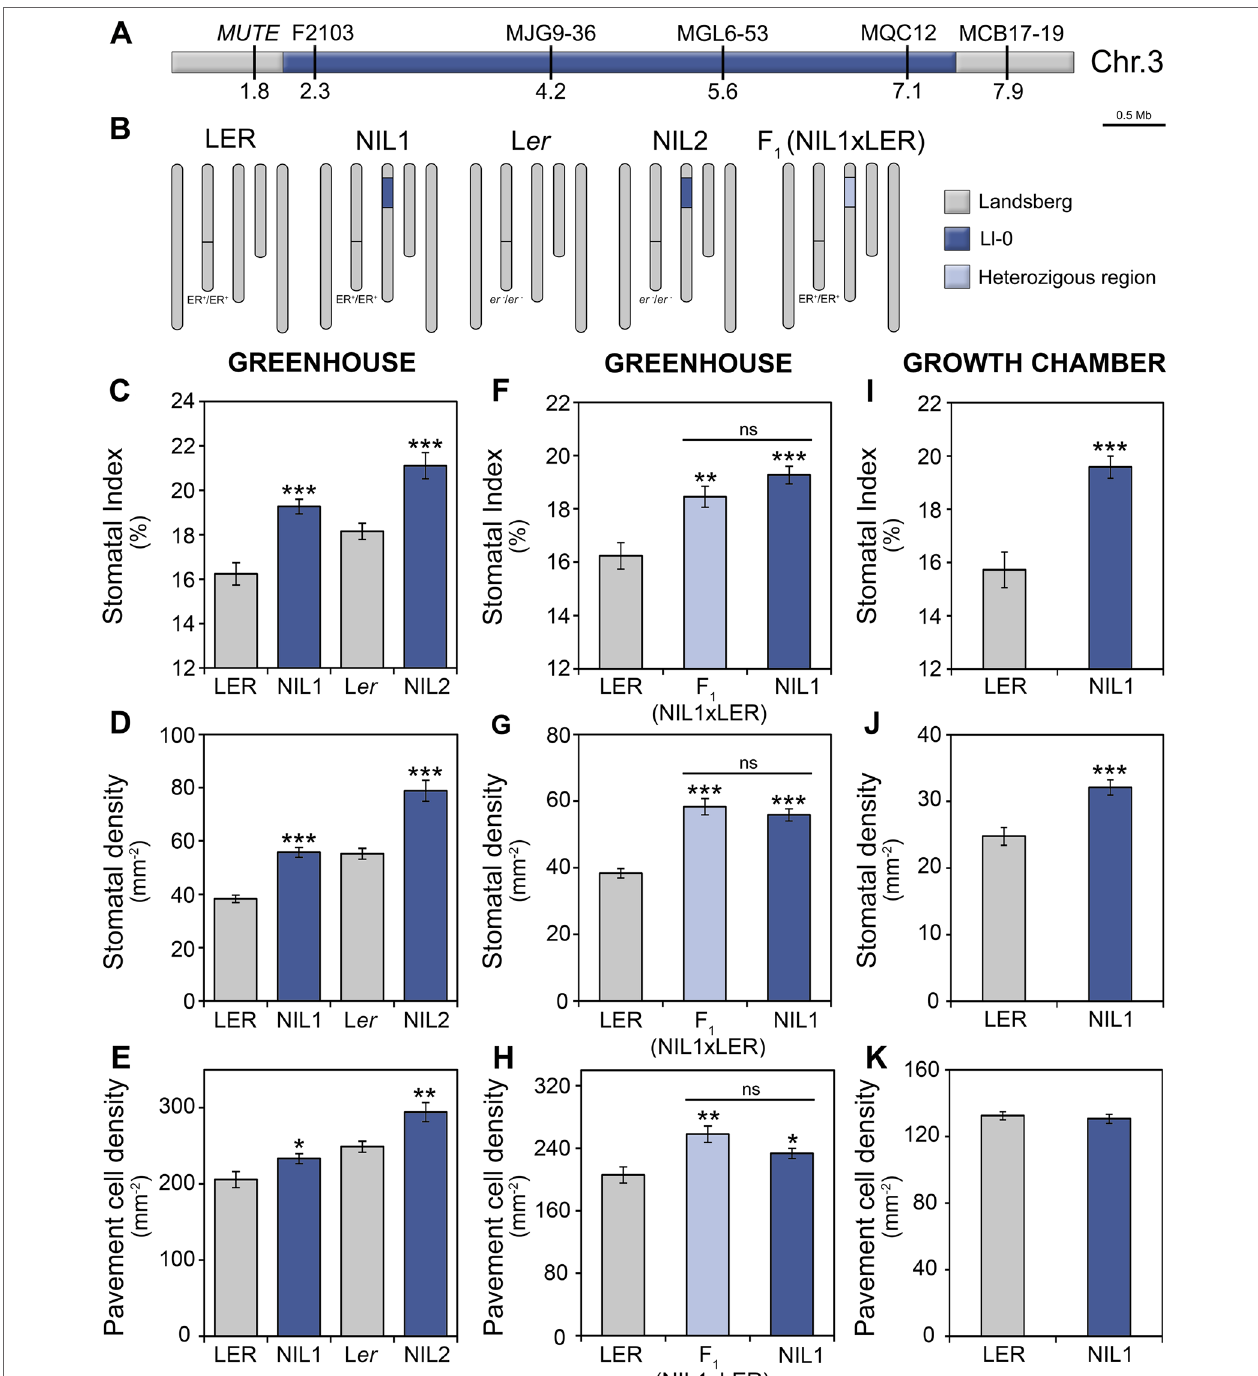
FIGURe 5 | Characterization of stomatal abundance related phenotypes of MID3 in NILs. (A) Physical map of the MID3 region on chromosome 3, indicating marker names and positions in megabases (Mb). (B) Graphical genotypes of NILs, their reference strains and the F 1 hybrids. NILs carried Ll-0 alleles at the MID3 region in L ER ( ER ; NIL1) or L er ( er-1 ; NIL2) background. The color code indicates homozygous and heterozygous regions for Landsberg and Ll-0 alleles. (C – K) Stomatal abundance related traits in the adaxial cotyledon epidermis of 21 dag plants. Stomatal index (C , F , I) , stomatal density (D , G , J) , and pavement cell density (e , h , K) were scored in the genotypes and growth environments indicated. Each panel shows the mean ± SE of 10–20 plants. Significant differences (*** P ≤ 0.001; ** P ≤ 0.01; * P ≤ 0.05; Student's t -test) with respect to the reference strain (L ER or L er ) are indicated by asterisks. ns, not significant.